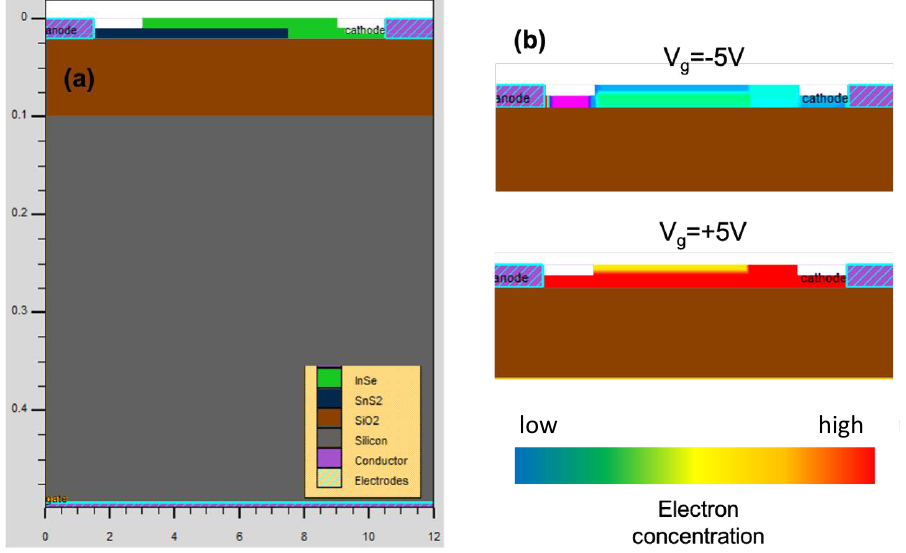
Figure 5. ( a ) Schematic of the simulated structure (500 nm × 12 µ m). ( b ) Carrier concentration at positive and negative gate voltage in the channel.